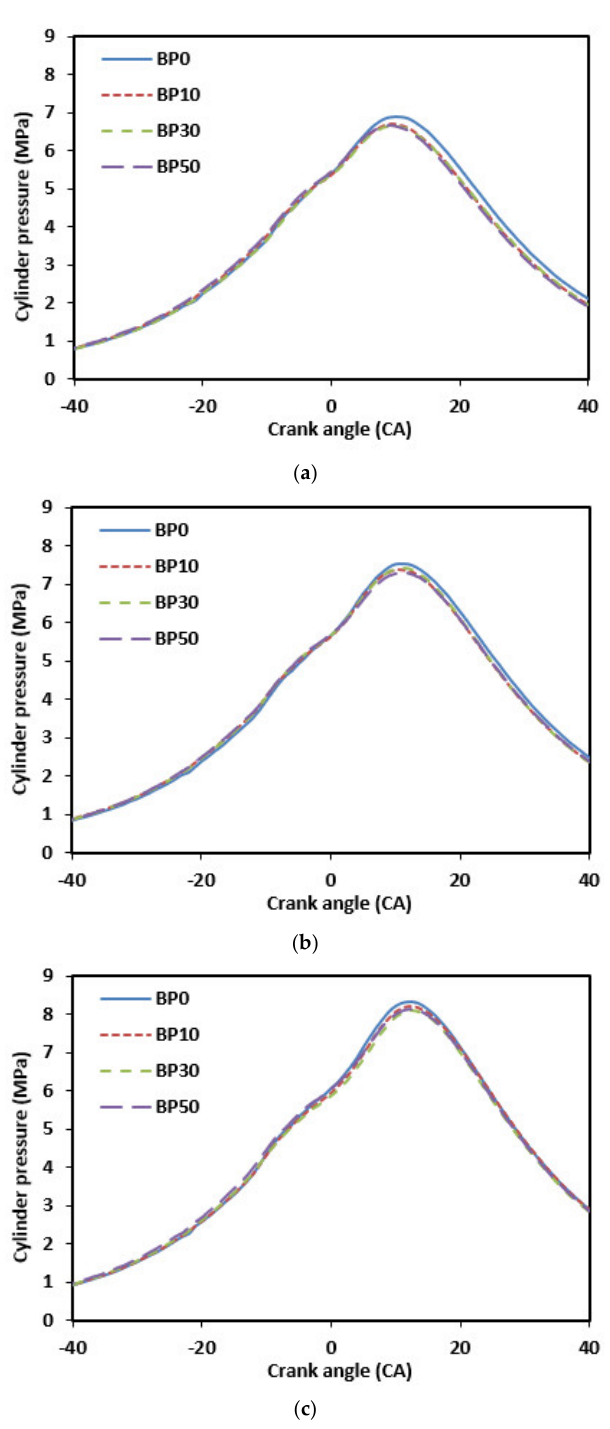
Figure 2. In-cylinder pressure for all test fuels at ( a ) 30 Nm, ( b ) 60 Nm and ( c ) 90 Nm.